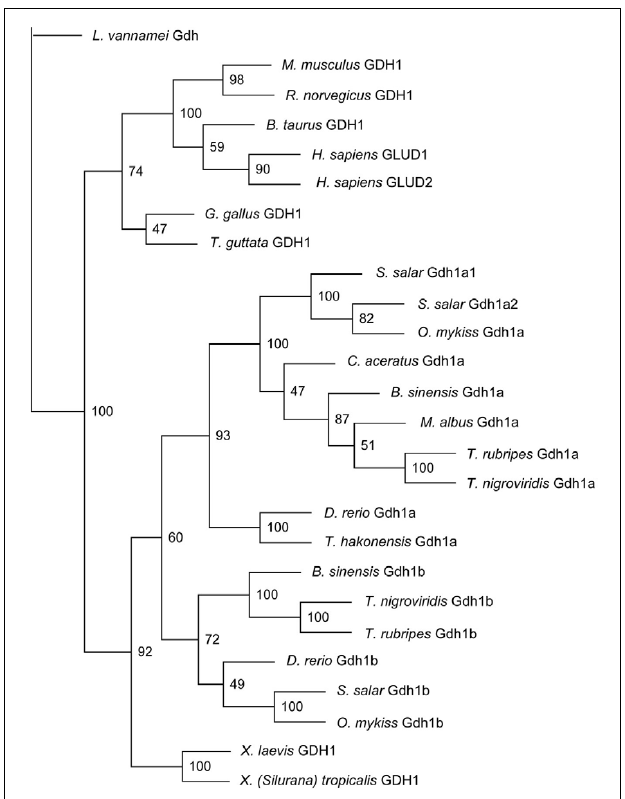
FIGURE 3 |The phylogenetic tree of several vertebrate glutamate dehydrogenase (Gdh) protein sequences and Monopterus albus Gdh1a sequence. Litopenaeus vannamei Gdh sequence was used as the outgroup. Bootstrap values are indicated at the nodes of tree branches. The sequences used in the tree and their respective accession number in either GenBank or Ensembl databases were presented in the Section “Materials and Methods.”